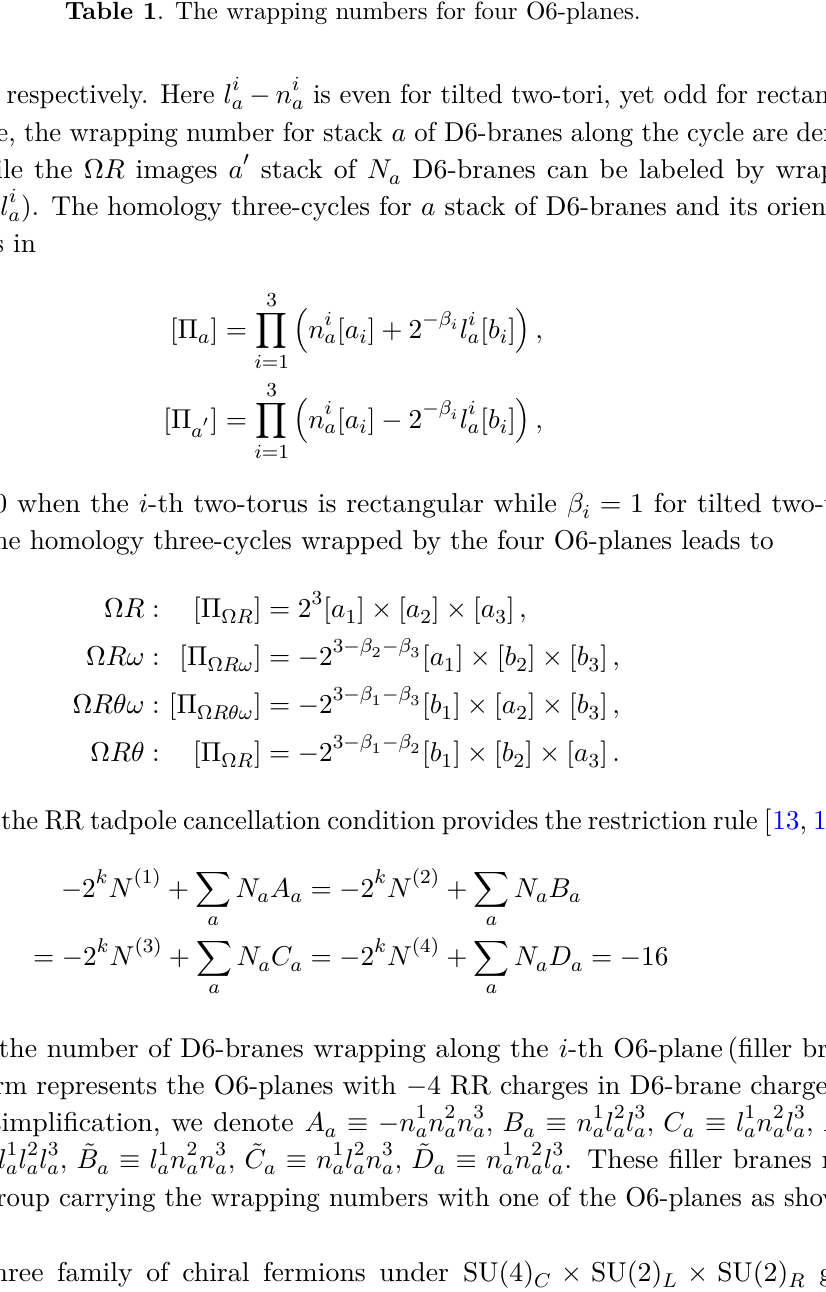
Table 1 . The wrapping numbers for four